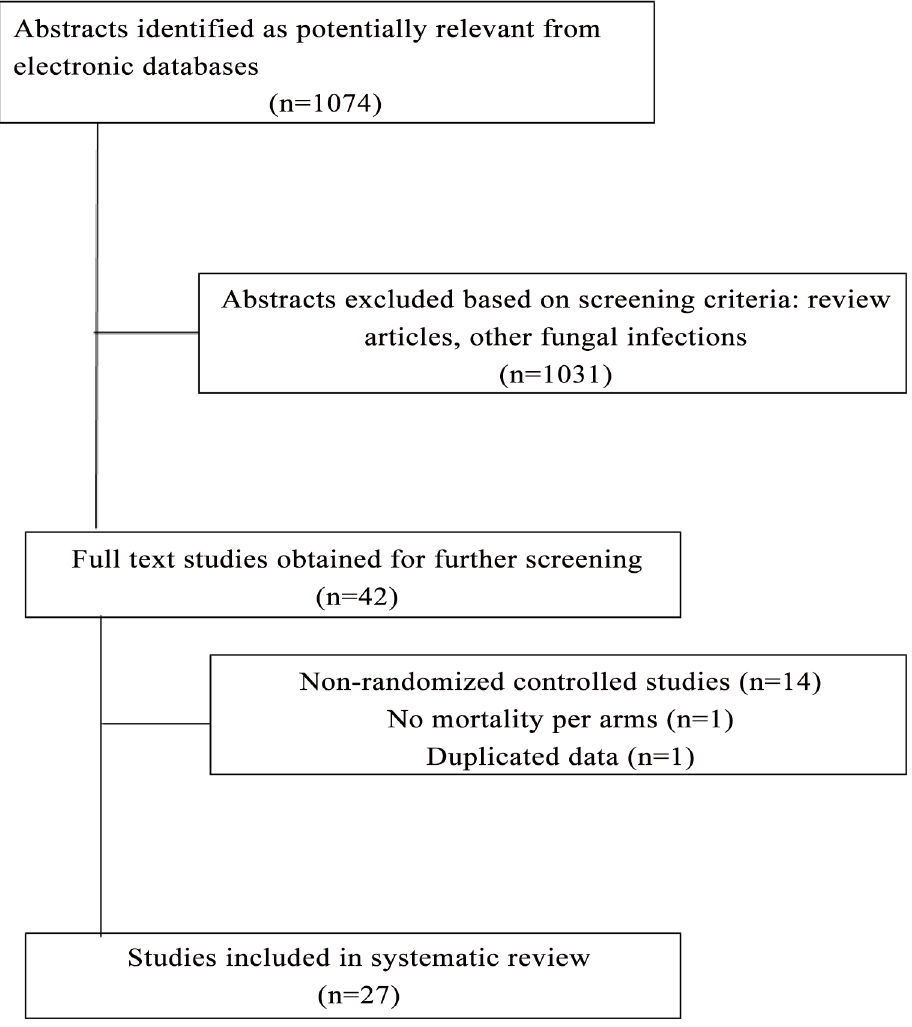
Fig 1. Flow diagram of search strategy and studies